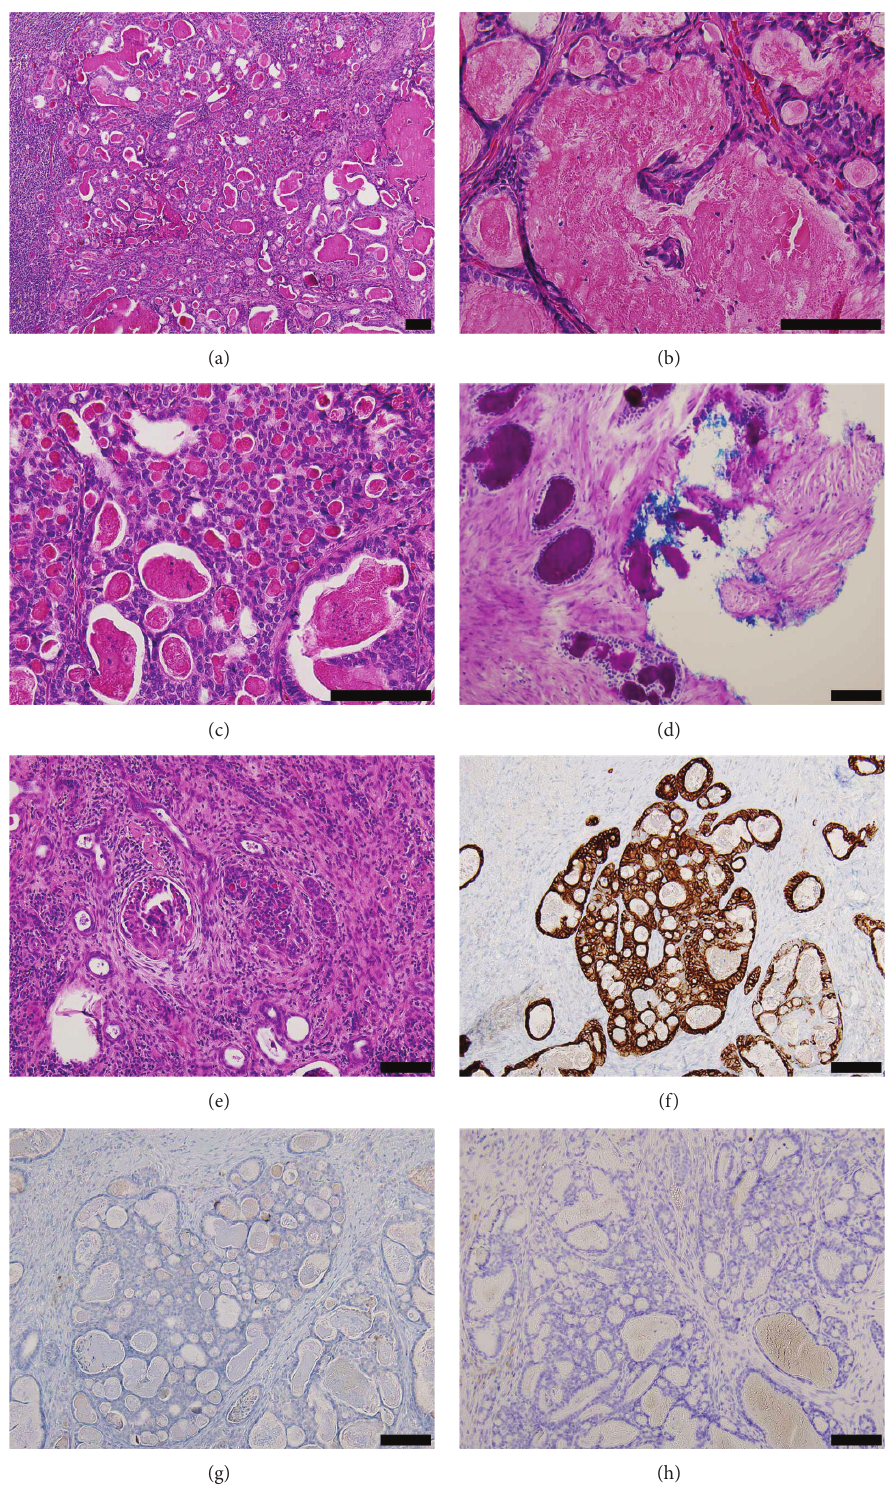
Figure 4: Histologic and immunophenotypic features of TLFCK. (a) Low power view of tumor demonstrated follicles of variably sized and shaped follicles filled with dense eosinophilic material. (b) Papillary-like structure extending into lumen of a macrofollicle. (c) High power view of microfollicular area. (d) Tumor extended to renal capsular surface (blue ink), with periodic-acid-Schiff (PAS) positive diastase resistant material identified within follicular lumens. (e) A focus of isolated tumor cells was located 1.8 mm from the main tumor. ((f)–(h)) Immunohistochemical staining of tumor cells showed reactivity for (f) CK7 and no reactivity for (g) TTF-1 or (h) thyroglobulin. Scale bars represent 100 𝜇